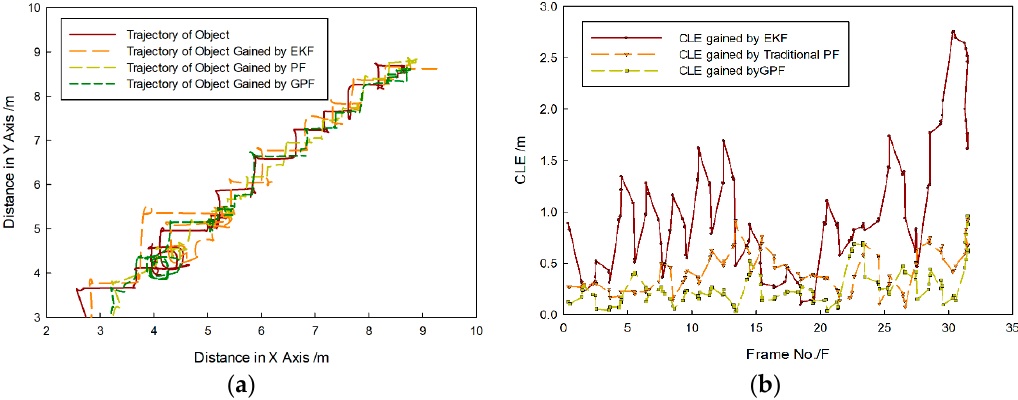
Figure 13. Comparison results obtained by different methods: ( a ) tracking trajectory gained by each method and ( b ) center-position-error (CLE) curve gained by each method.